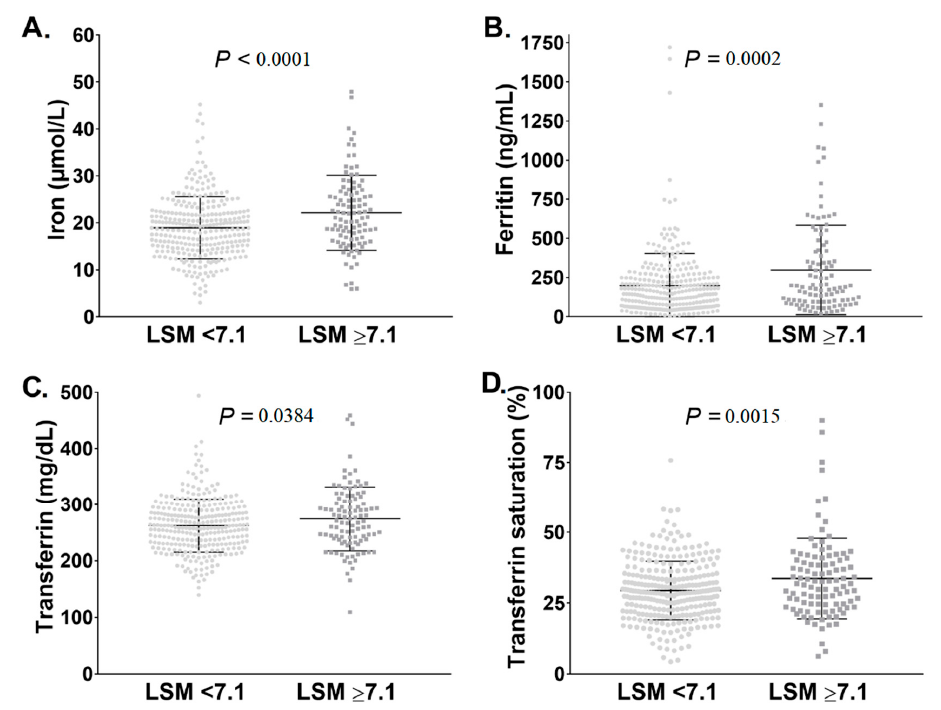
Figure 2. Parameters of iron metabolism in subjects homozygous for the Pi*Z variant (Pi*ZZ) with and without liver sti ff ness measurements (LSM) suggestive of significant liver fibrosis. Pi*ZZ individuals (n = 409) were subjected to non-invasive assessment by transient elastography (FibroScan ® ). A previously described cut-o ff of 7.1 kPa for LSM [7], suggestive of the presence of significant liver fibrosis, was used. Serum iron (adjusted p value = 0.0002) ( A ), serum ferritin (adjusted p value = 0.0106) ( B ), serum transferrin (adjusted p value = 0.0211) ( C ), and serum transferrin saturation (adjusted p value = 0.0080) ( D ) values were compared between Pi*ZZ subjects with LSM below and above 7.1 kPa. Multivariable adjustments were performed for the covariates age, sex, BMI, presence of diabetes mellitus, and mean alcohol